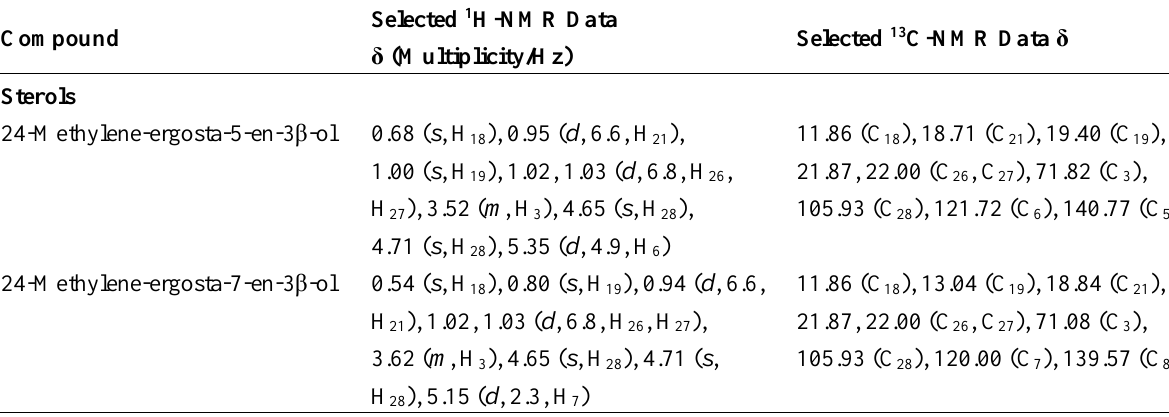
Table 3. NMR data of the identified black rice bran sterols and